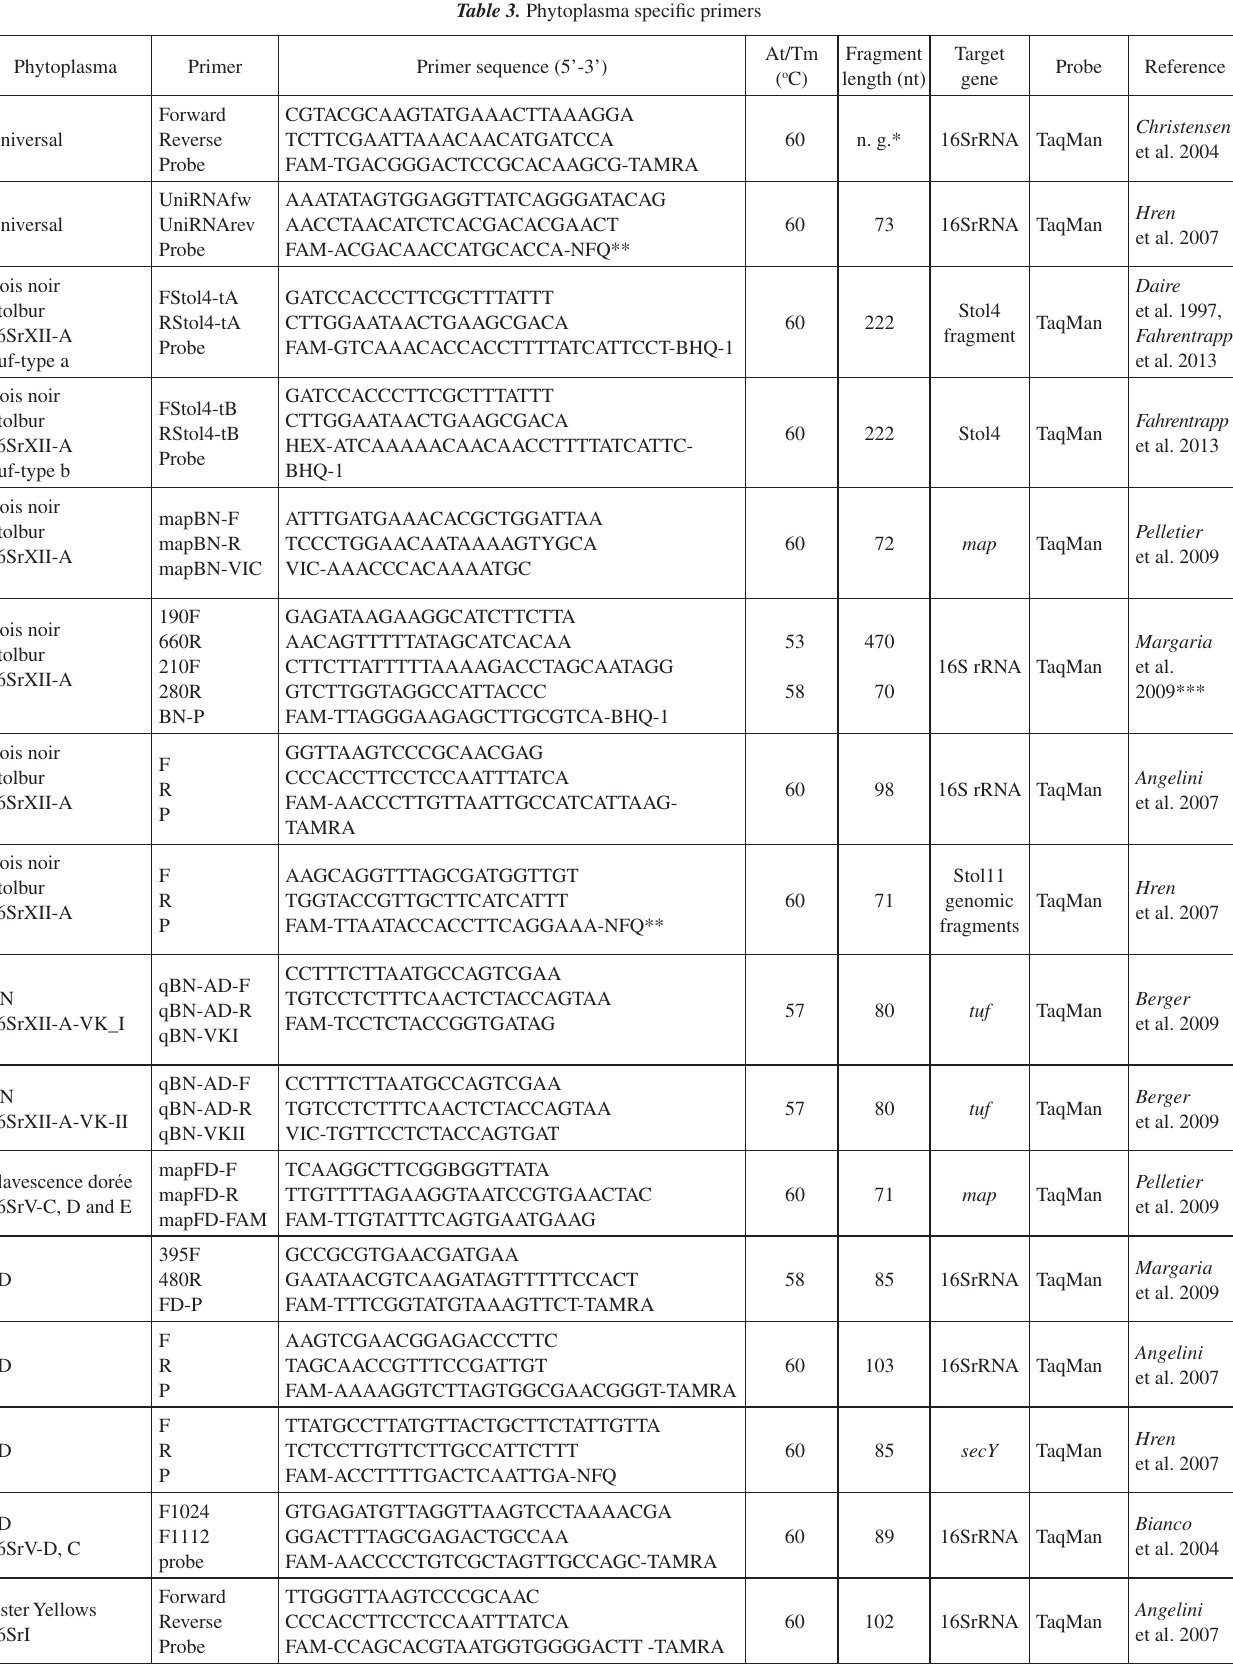
Table 3. Phytoplasma specific